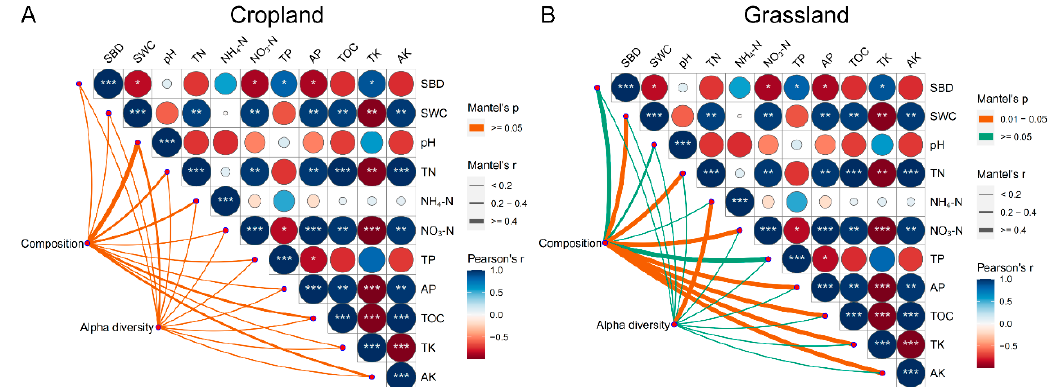
Figure 3. Mantel test of environmental variables with their corresponding composition and alpha diversity of bacterial communities in cropland ( A ) and grassland soils ( B ). The list of abbreviations is as follows: soil bulk density (SBD), soil water content (SWC), pH, total nitrogen (TN), ammonia nitrogen (NH 4 -N), nitrate-nitrogen (NO 3 -N), total phosphorus (TP), available phosphorus (AP), total potassium (TK), available potassium (AK), and organic matter (OM). *** shows the significant difference at the 0.01 level, ** shows the significant difference at the 0.01 level, and * shows the significant difference at the 0.05 level.